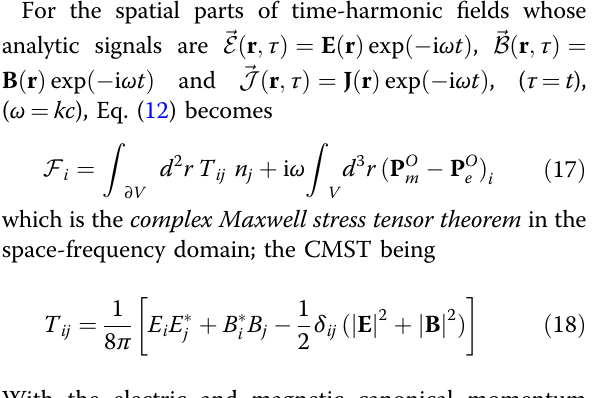
dent fi eld, like e.g., an ultrashort pulse), which gives rise to an accretion of reactive strengtht of canonical momentum , ROM, around the body. As such, this ROM is not associated to the scattered fi eld radiated into the far-zone, i.e., to the “ radiated ” RMST, but to reactive power, and thus it remains inside and in the near- fi eld of the object volume V . In this regard, we remark that 0 this fi eld imaginary momentum exchange is opposite to that of fi eld (i.e., Poynting) time-averaged momentum, thus substracting, rather than adding, to the variation of imaginary linear momentum. This means that ~ although the light wave loses fi eld momentum G R on ~ interaction, it may gain reactive fi eld momentum G I , even when it does not exist in the illuminating fi eld.